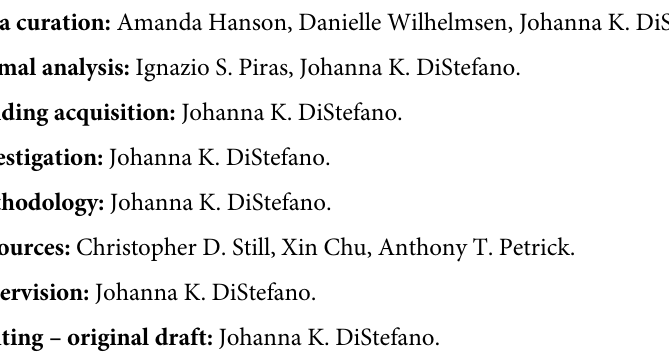
S1 Table. Patient demographics and clinical characteristics. S2 Table. Features of AEBP1 repression strength by seven miRNAs identified using predic- tive